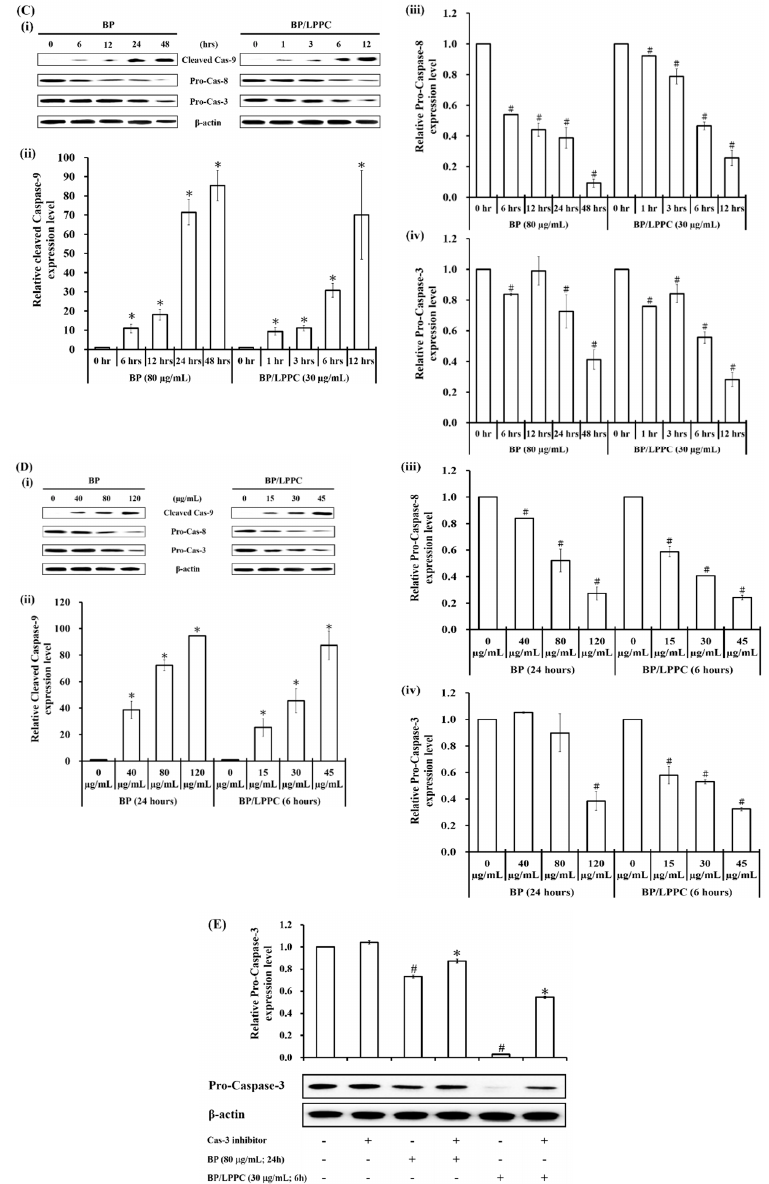
Figure 3. BP/LPPC-induced apoptosis morphology and associated protein expression on B16/F10 cells. ( A ) BP or BP/LPPC-treated cell showed TUNEL positive results and apoptotic cell morphology,